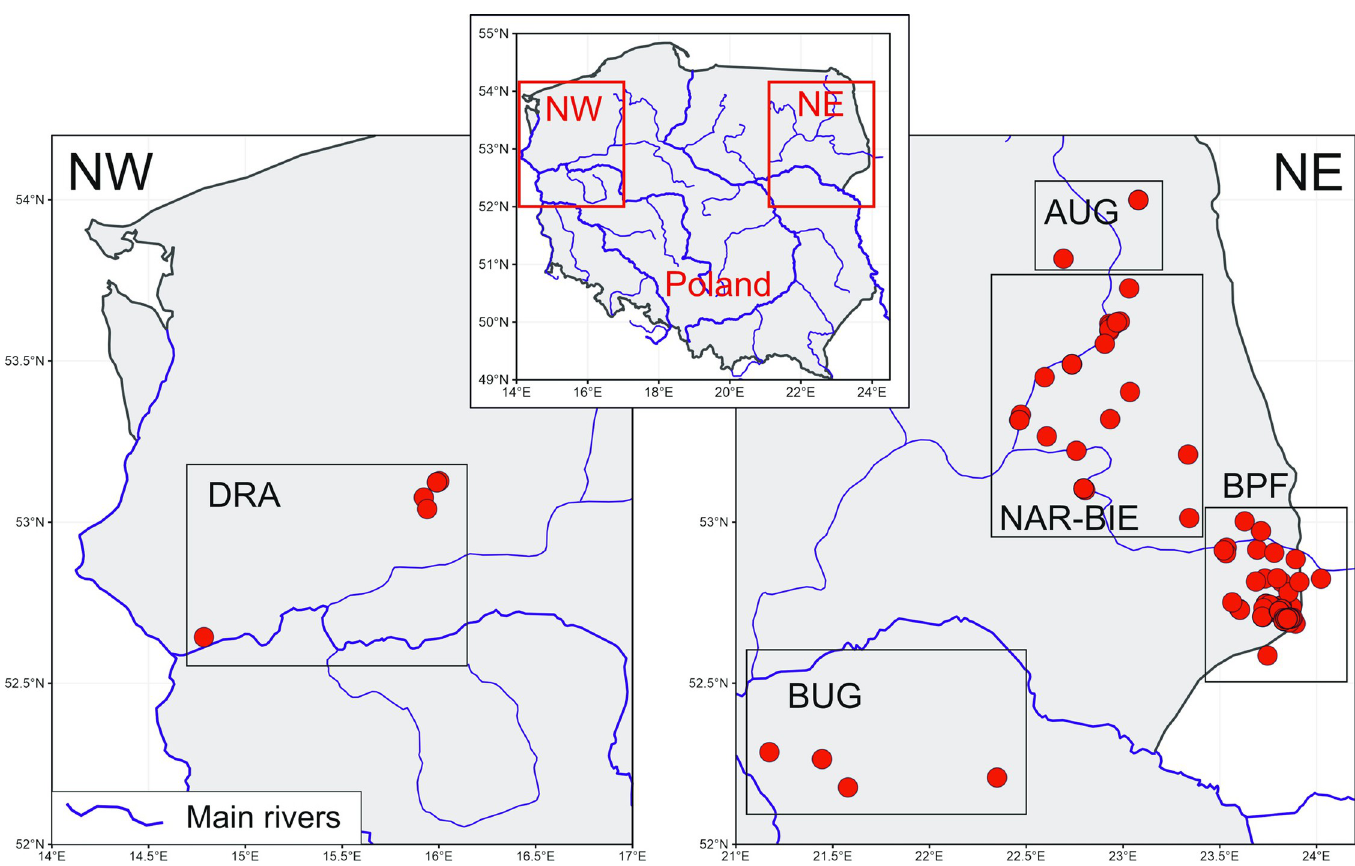
Fig 1. Map with the sample localities. AUG–Augusto´w Forest; NAR-BIE–Narew and Biebrza river basins; BPF–Białowie ż a Primeval Forest; BUG–Bug river basin; DRA– Drawa and Warta river basins. Background map: Natural Earth (public domain).